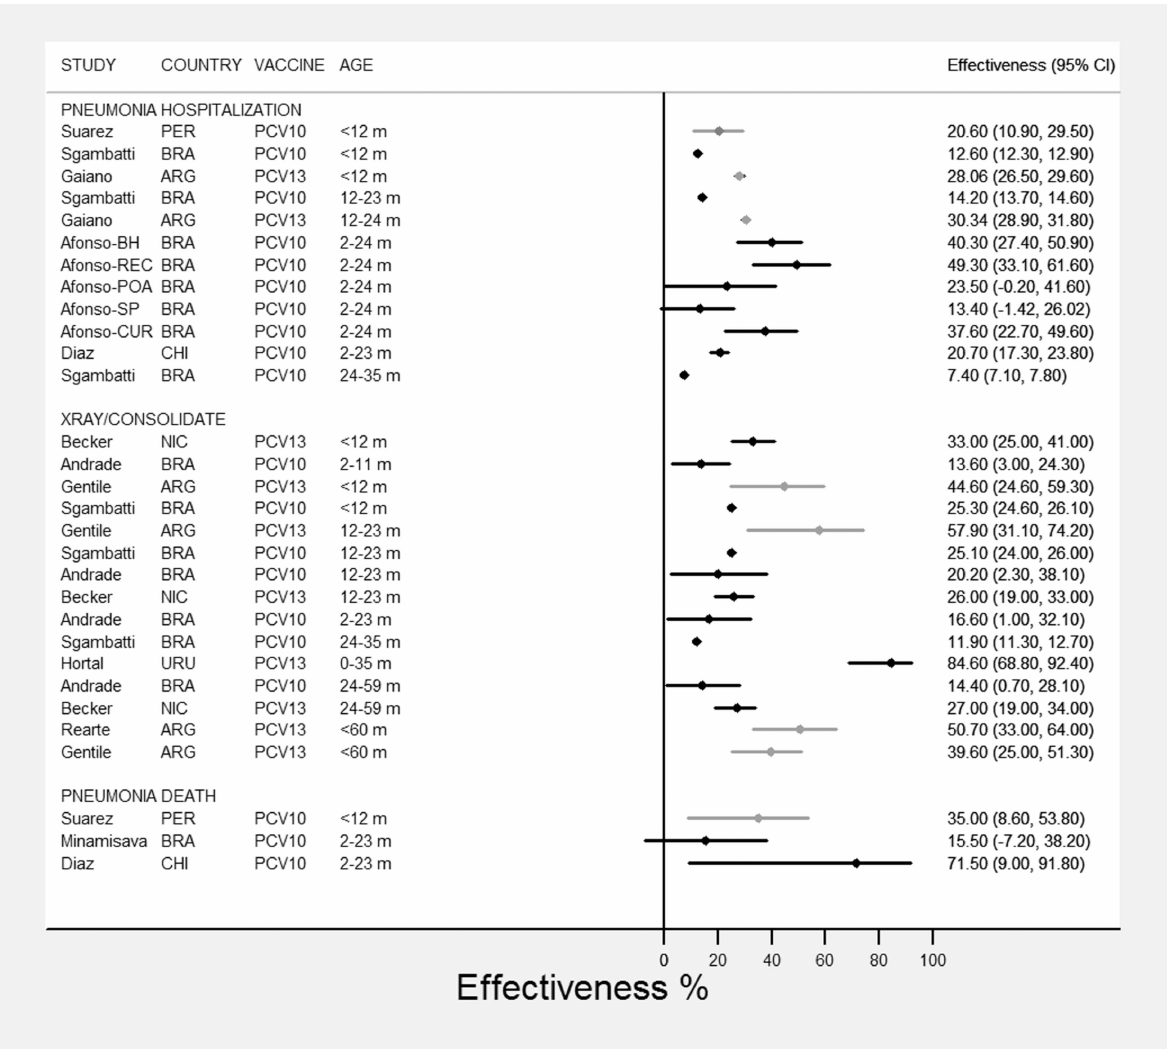
Fig 2. Vaccine effectiveness (%, 95% confidence interval * ) against pneumonias clinical and X-Ray/consolidated, by vaccine, group of age, and hospitalization or death. * Effectiveness estimates and 95%CI are presentedin black for studies assessing hospitalized pneumonia, and in light gray for studies assessingcombinedpneumonia inpatientand outpatients as endpoints. Two studies with no availableconfidenceintervalswere not plotted: Hortal et al.[17]; Scotta et al.[27] Countries:ARG (Argentina); BRA (Brazil); CHI (Chile); NIC (Nicaragua); PER (Peru); URU